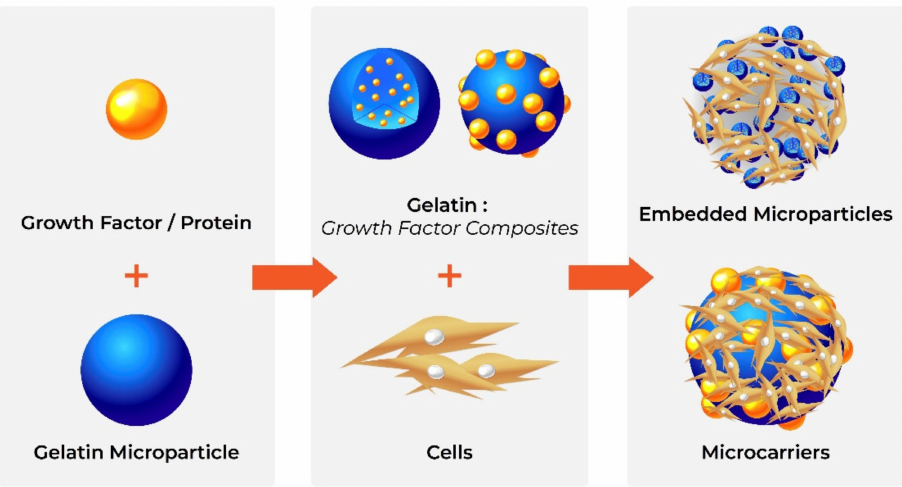
Figure 3. Loading of gelatine microparticles with growth factors and/or cells to direct cellular differentiation (based on